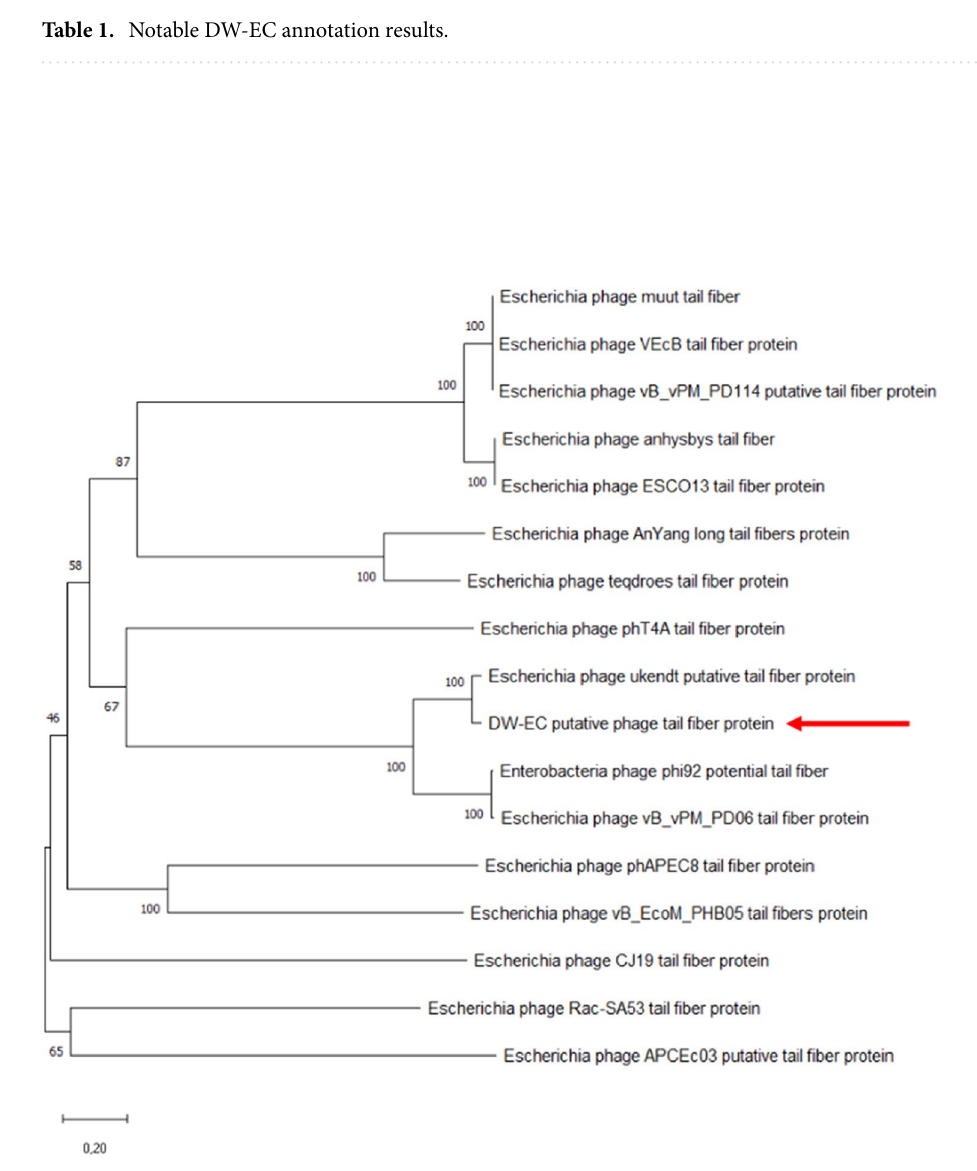
Figure 2. Unrooted phylogenetic tree of DW-EC tail fiber protein and other related phages taken from NCBI database (100 bootstrap, 20% homology). DW-EC is indicated by arrows ( ←